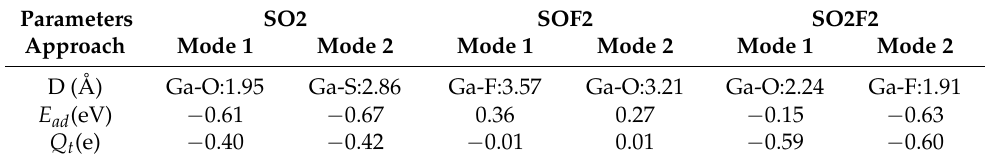
Figure 7. Structure of ( a1 , a2 ) SO 2 adsorption mode, ( b1 , b2 ) SOF 2 adsorption mode, ( c1 , c2 ) SO 2 F 2 adsorption mode. Table 4. Parameters of gas adsorption on Ga-MoS 2 in different approaches.